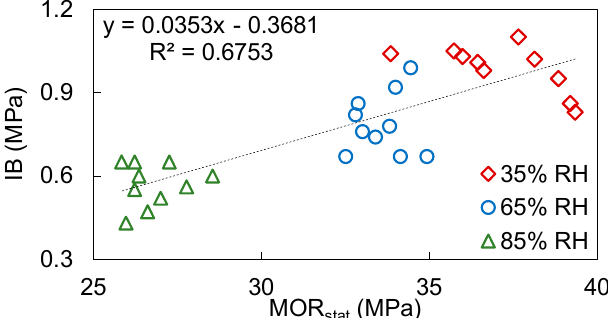
Figure 3. Linear relationship between MOR stat and internal bond (IB) strength of the Medite Tricoya ® MDF samples conditioned at three different humidity.